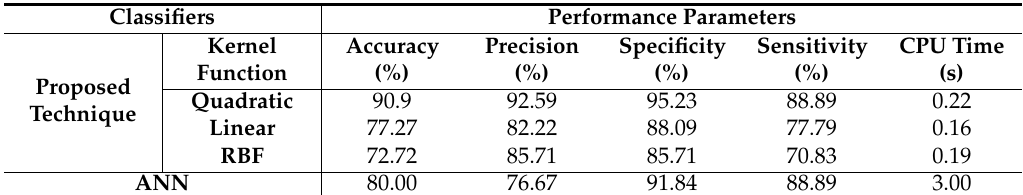
Table 5. The optimum statistical parameters values of the classifiers and the central processing unit (CPU) times consumed for training.